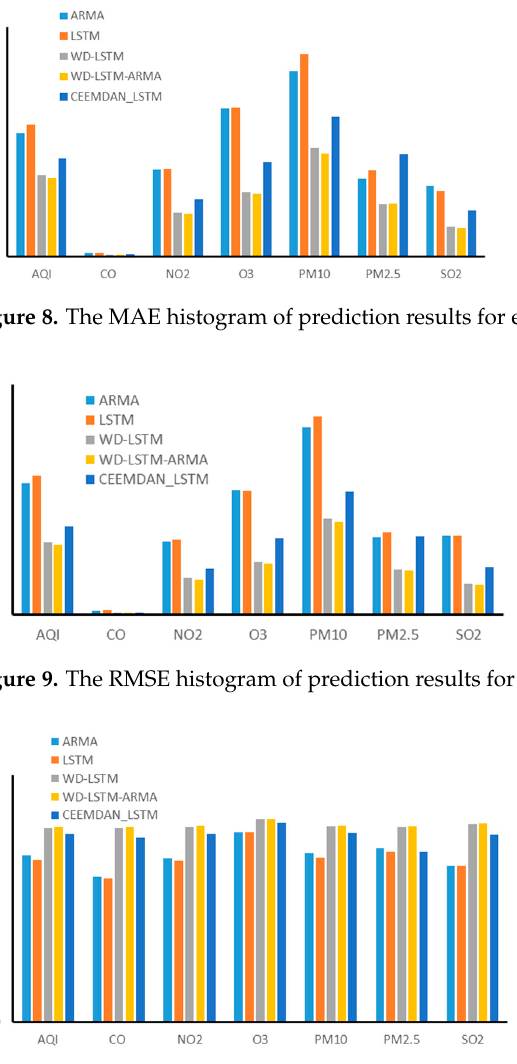
Figure 10. The R 2 histogram of prediction results for each model.